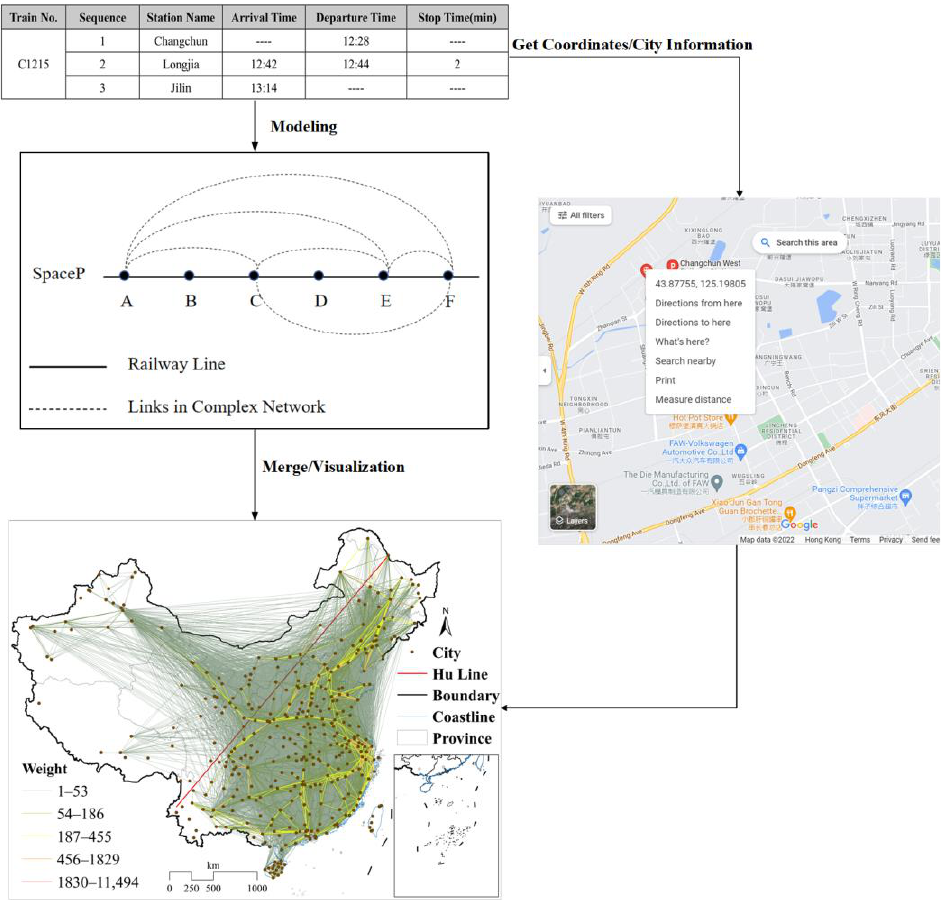
Figure 2. The construction process of the geographical railway network.